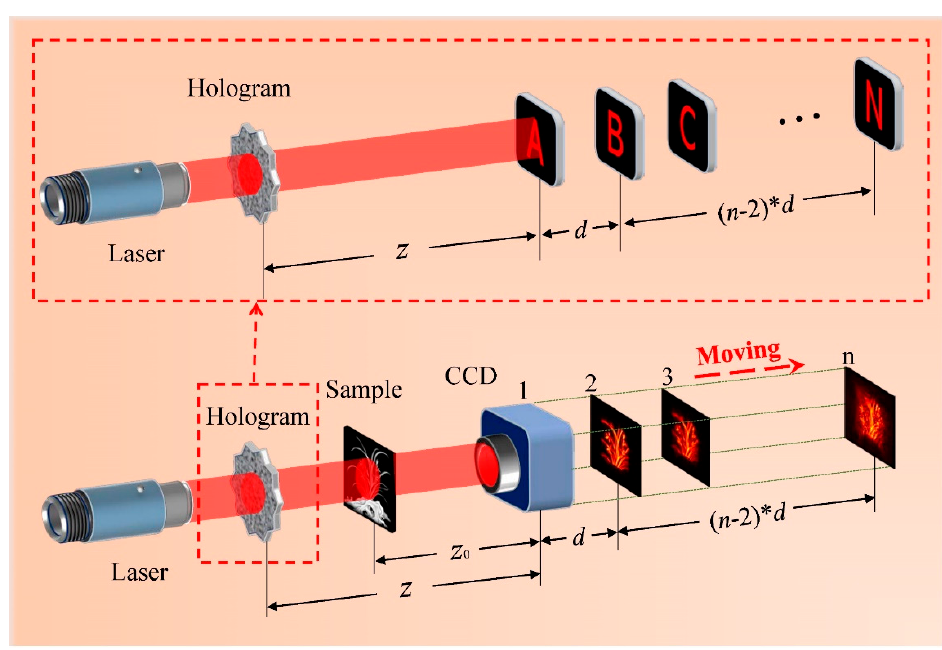
Figure 1. Imaging system of the proposed phase retrieval method.